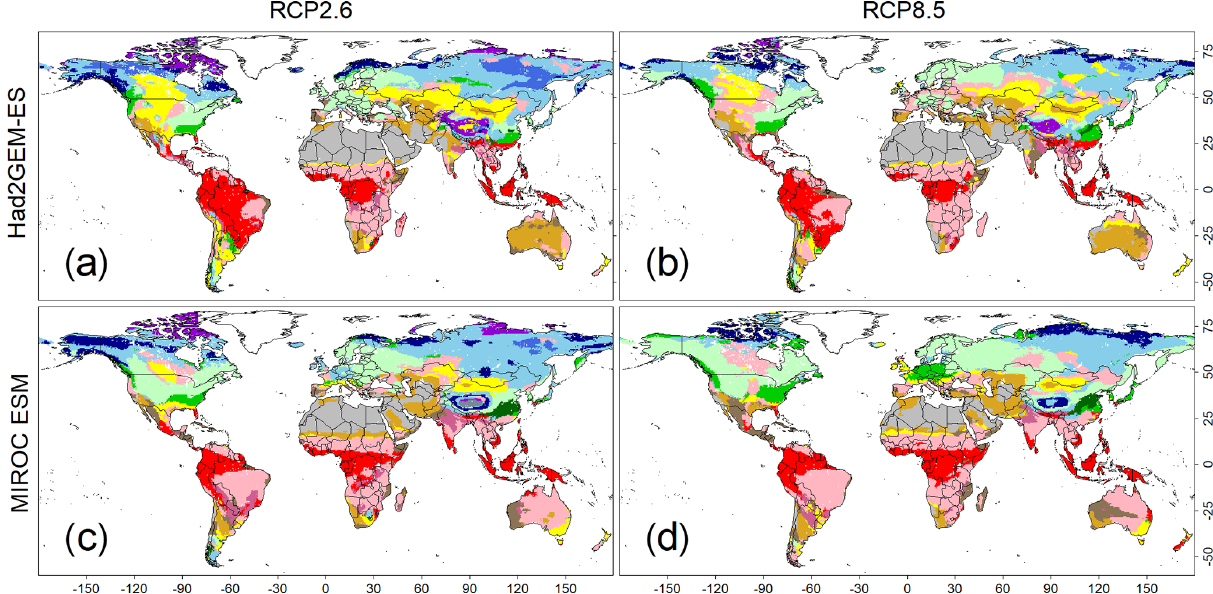
Figure 5. Predicted biome maps under climatic scenarios from 2091 to 2100. Monthly means of four sets of forecasted climatic conditions derived from combinations of two climate models (i.e. Had2GEM-ES and MIROC-ESM) and two RCP scenarios (i.e. RCP2.6 and RCP8.5). These means were applied to the CNN model that was trained by the current biome distribution map, as well as the present climatic condition derived from the CRU dataset. Colour definitions are available in Fig.